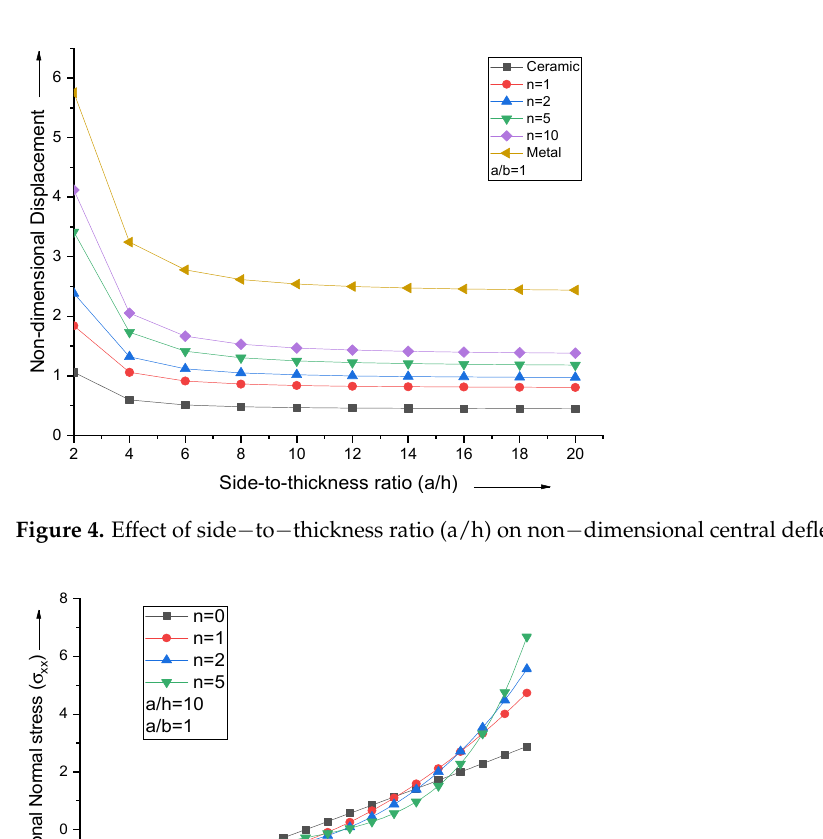
Figure 5. Effect of volume fraction index (n) on non − dimensional normal stresses of the plate. When the aspect ratio is varied, the extremum of non-dimensional normal stress at the top and bottom surfaces of the FGM plate decreases with the increase in aspect ratio. The non-dimensional normal stress curves attain zero at Z = 0.075 for all aspect ratios of the FGM plate with n = 2, as shown in Figure 6.